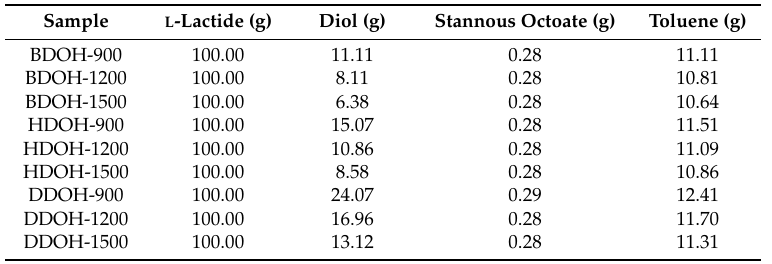
Table 1. Formulations of the as-synthesized